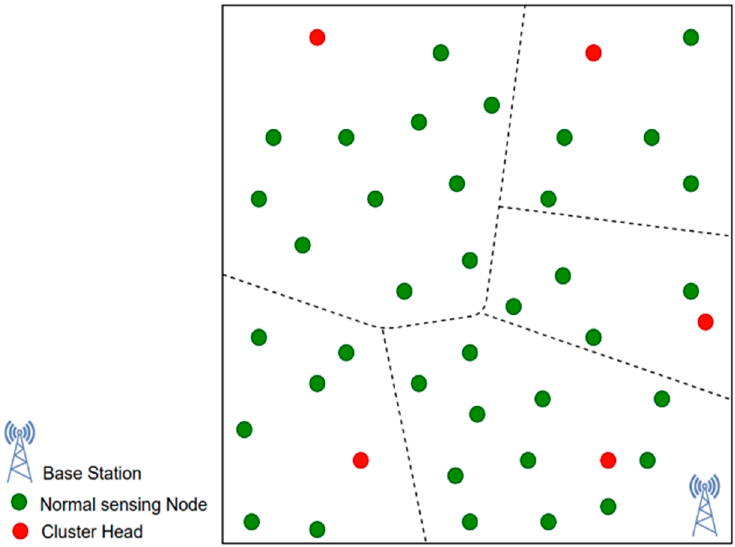
Figure 2. Depiction of random distribution of cluster heads in conventional LEACH protocol. The work was carried out by considering both friendly and hostile